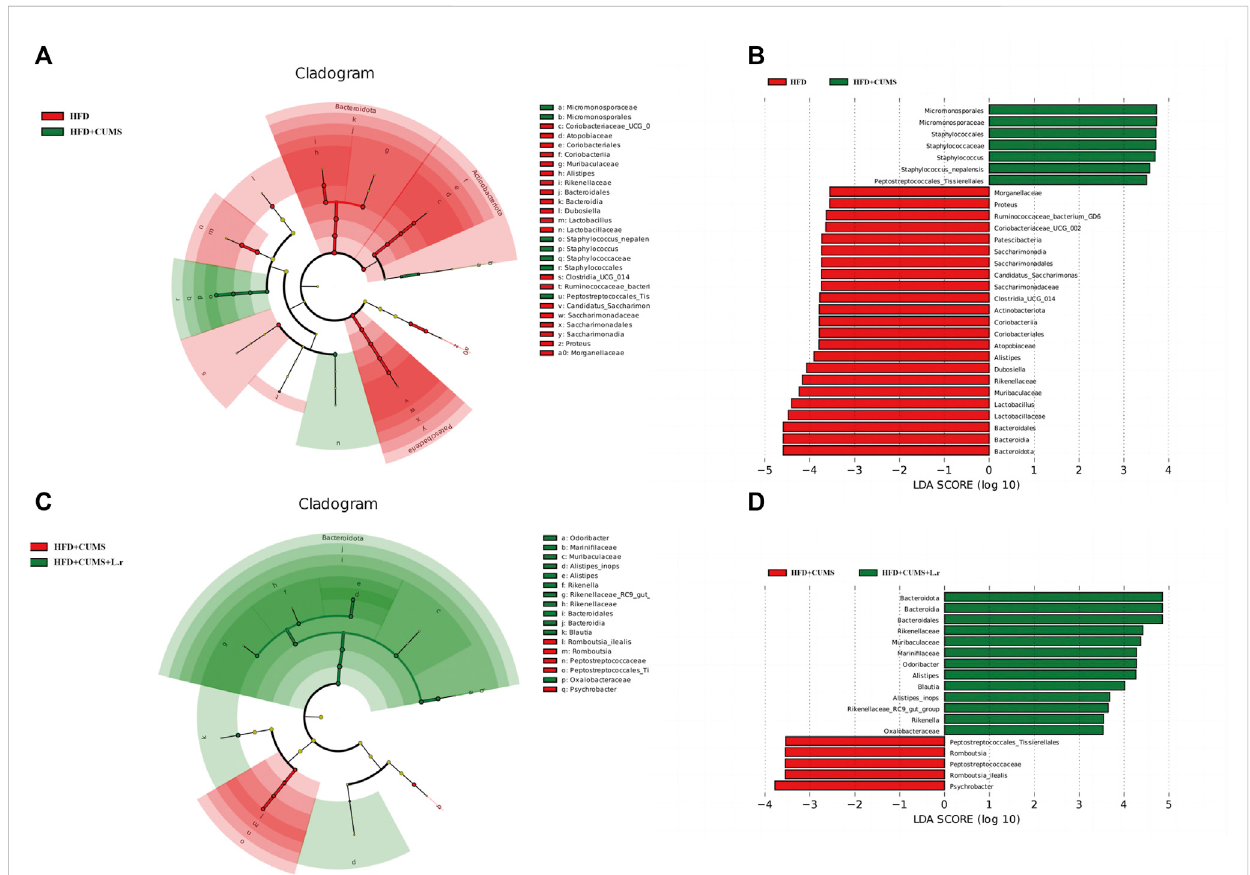
FIGURE 9 Biomarker analysis of the gut microbiota community ( n = 8/group). (A) LEfSe cladogram represents the taxa enriched in the HFD group (Red) and HFD + CUMS group (Green). (B) Discriminative biomarkers with an LDA score > 3.5 between the HFD group (Red) and HFD + CUMS group (Green). (C) LEfSe cladogram represents taxa enriched in the HFD + CUMS group (Red) and HFD + CUMS + L.r group (Green). (D) Discriminative biomarkers with an LDA score > 3.5 between the HFD + CUMS group (Red) and HFD + CUMS + L.r group